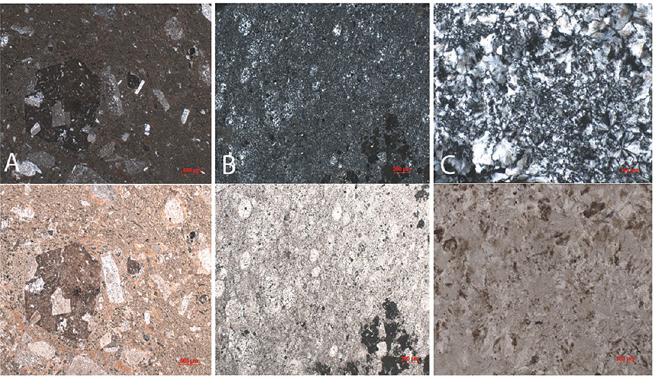
Fig 6. Photomicrographs of A) porphyry, B) shale, and C) chert under XPL (upper) and PPL (lower) lights that were tested by means of